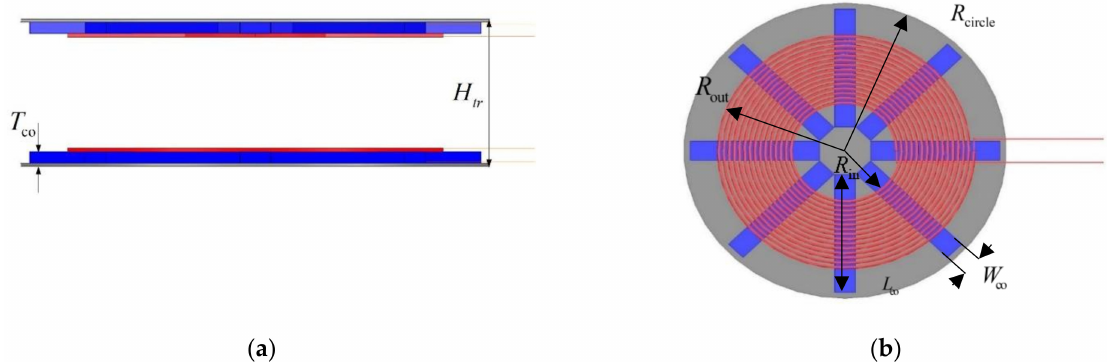
Figure 3. Dimensioning map of the circular structure in 2-D: ( a ) side view; ( b ) primary